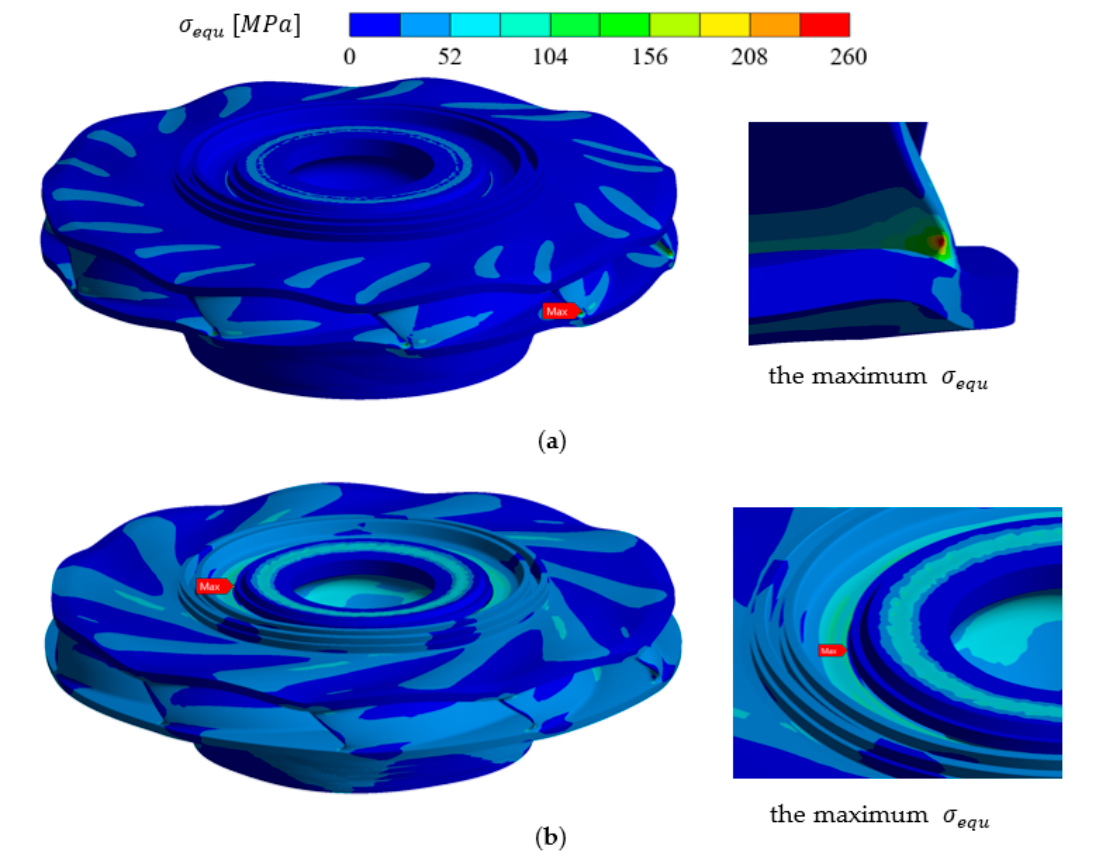
Figure 10. Stress distribution at start ‐ up process ( a ) TP3; ( b ) TP9. Further observation indicates that in the last two stages of start ‐ up process, stress concentration also appeared at the fillets of leading edge and crown. For further explana ‐ tion of the stress characteristics during start ‐ up process, five nodes were selected in the high stress regions and marked as S1–S5, as shown in Figure 11. S2 and S3 locate at splitter blade while S4 and S5 locate at the main blade.